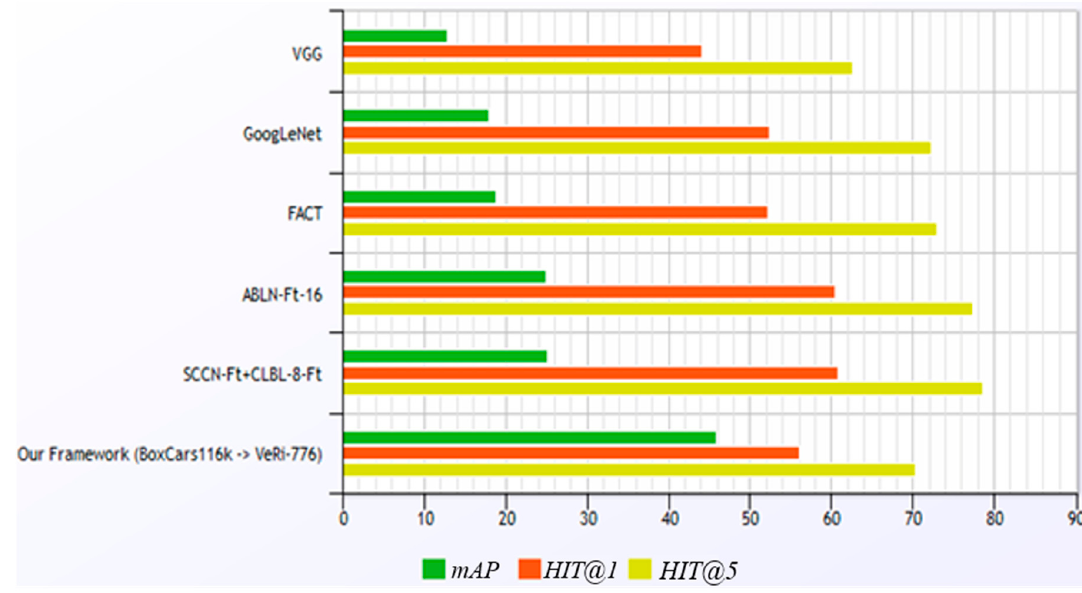
Figure 10. Shows the performance (%) comparison of our approach with other approaches on VeRi ‐